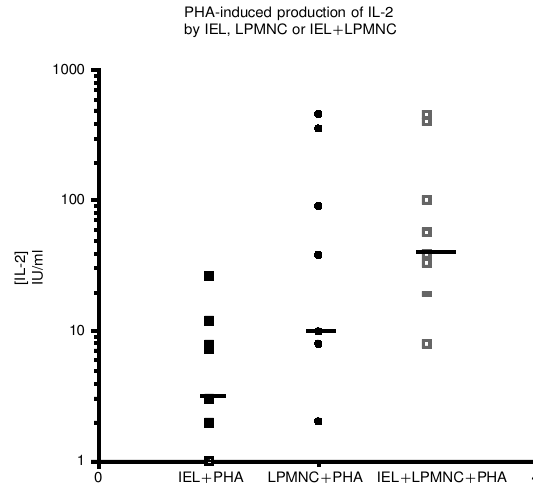
FIG. 2. Interleukin-2 concentration (IU ml) secreted by PHA- stimulated mucosal lymphocytes. IL-2 production by LPMNC is signi® cantly affected by the addition of IEL.